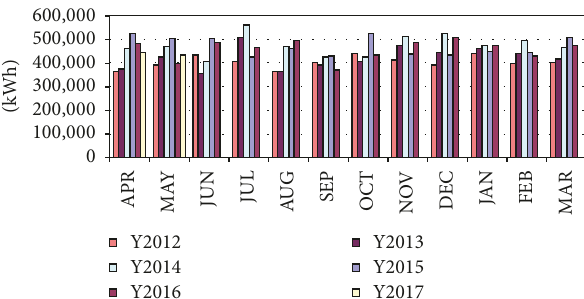
Figure 2: Power usage for the whole building from April 2012 to